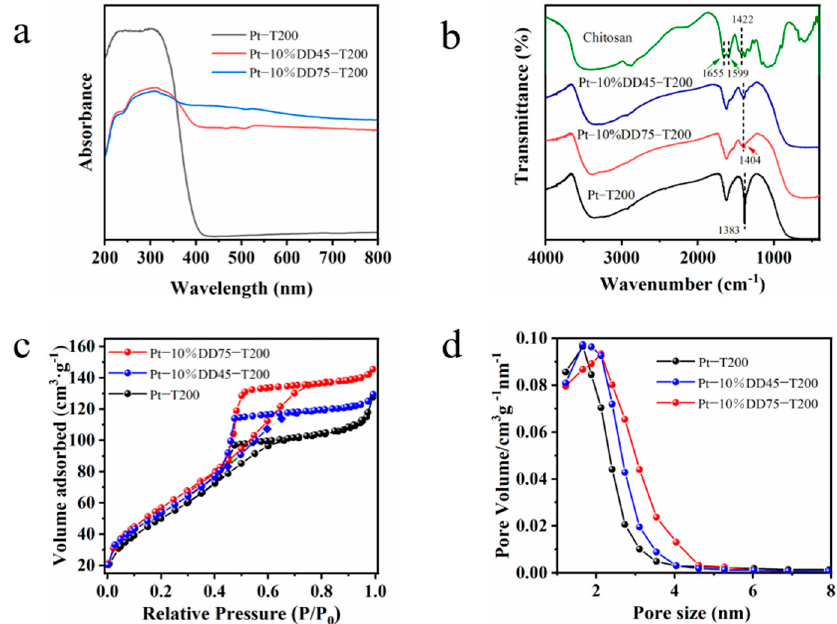
Figure 2. ( a ) UV–vis diffuse reflectance spectra, ( b ) FT-IR spectra, ( c ) N 2 adsorption-desorption isotherms, and ( d ) BJH pore size distribution of as-prepare Pt-Chitosan-TiO 2 samples.